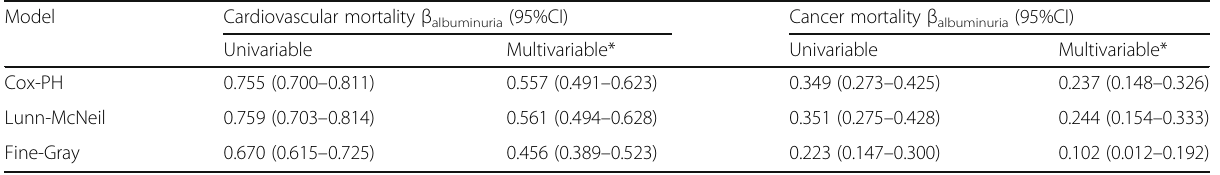
Table 3 Estimates for the effect of albuminuria status on cardiovascular and cancer mortality from univariable and multivariable proportional hazards models. Adjusted for age, gender, BMI, smoking status, SBP, HbA 1c and Total:HDL cholesterol ratio. β albuminuria refers to the model coefficient for the albuminuria variable